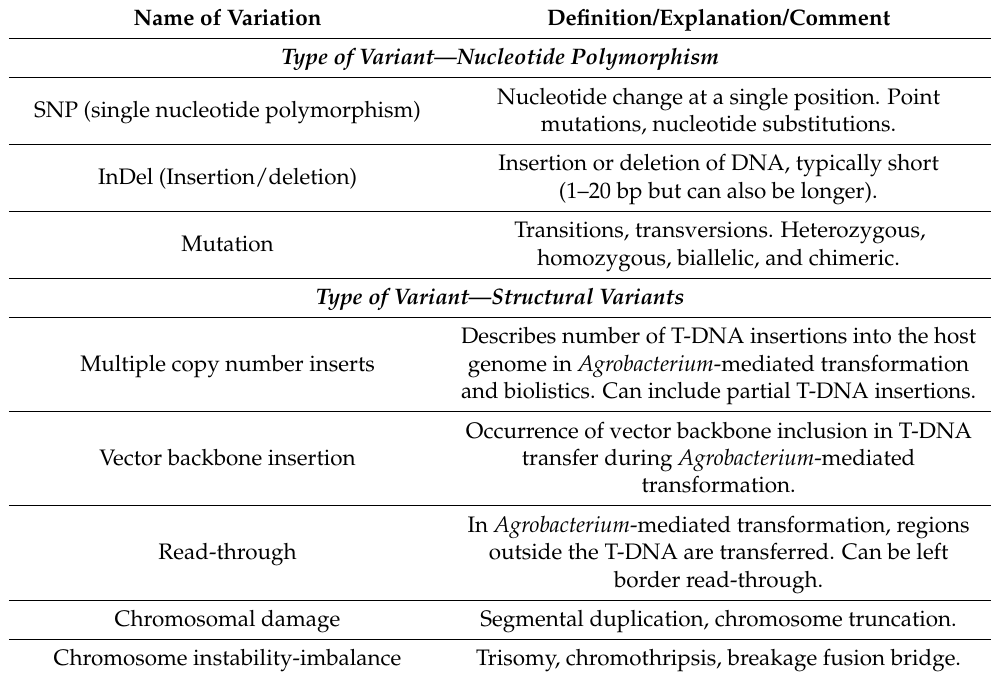
Table 1. Description of genomic variations.